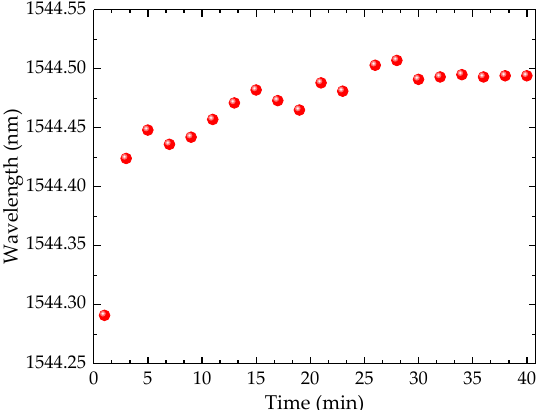
Figure 3. Peak wavelength dependence with time during the agarose curing process.